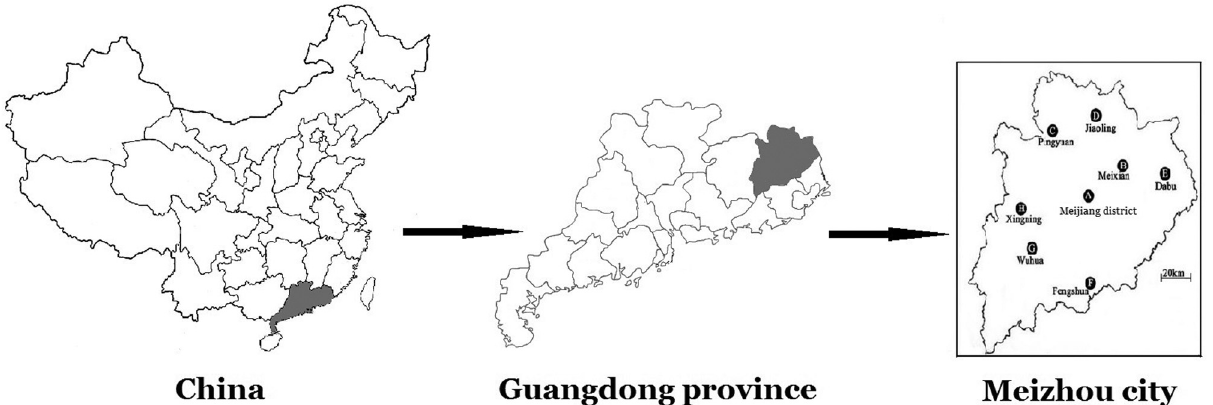
Figure 1 - Geographical position of Meizhou in Guangdong Province of